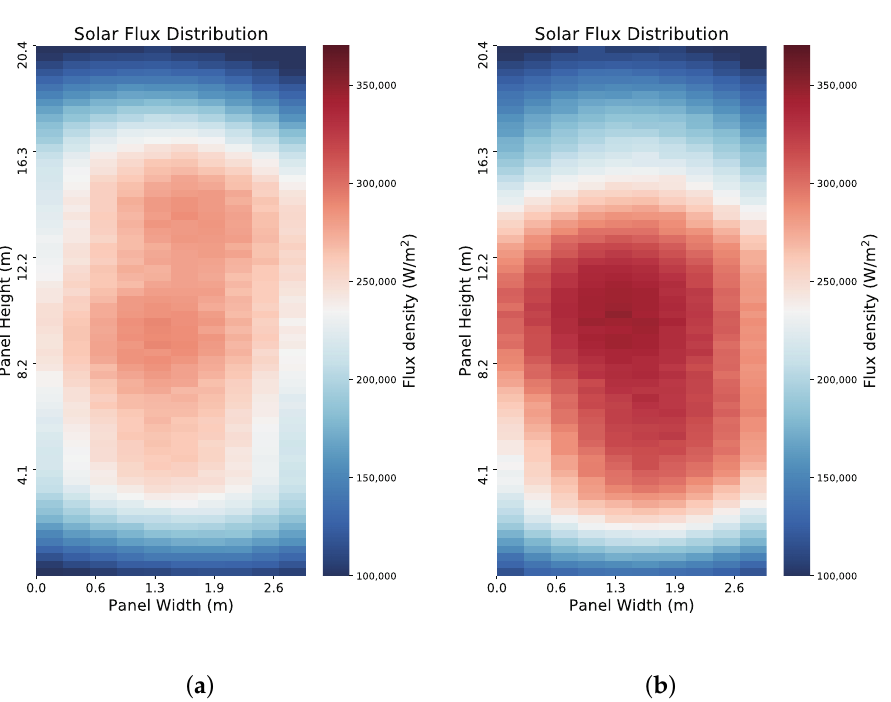
Figure 12. ( a ) Solar flux distribution generated without feedback compensation. ( b ) Solar flux distribution generated with feedback